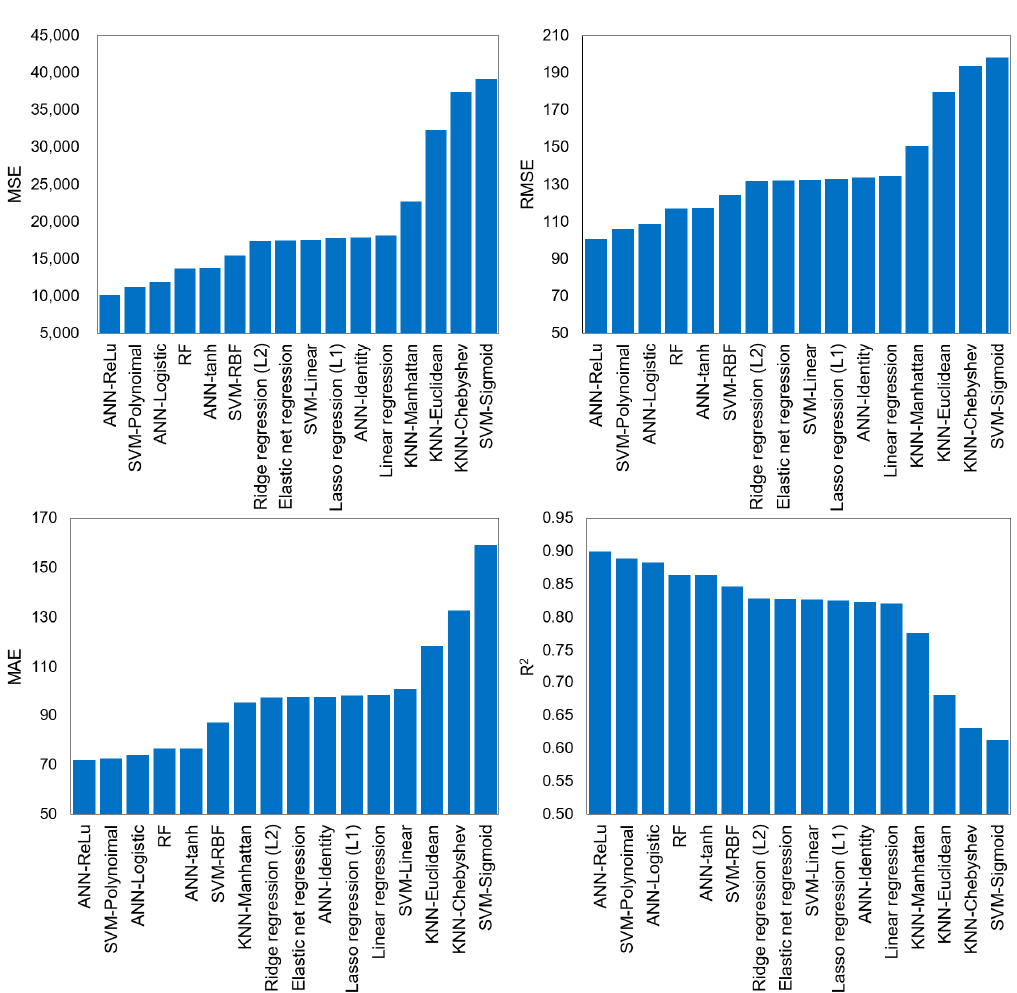
Figure 3. Performance results of ML models developed for DWGR prediction. Table 3. The ratio of percent deviation (RPD) performance of ML models developed for DWGR prediction.